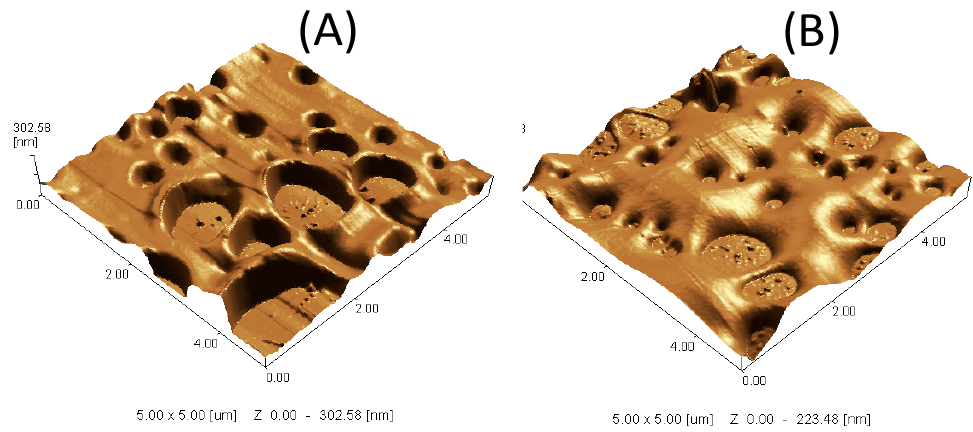
Figure 11. The scanning probe microscope (SPM) of the laminated PES layer on silicon dioxide slides: the blank laminated PES layer ( A ); and modified laminated PES layer ( B ). Modification condition: 15 mM 2-AP, pH 5.5 (0.1 M sodium acetate buffer), and 0.5 U · mL − 1 enzyme (laccase) modified for 120 min at 25 °C.